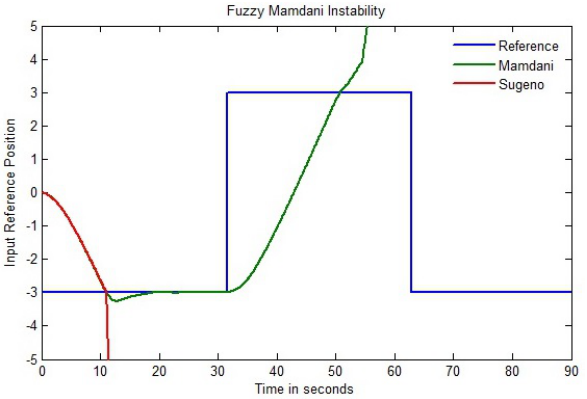
Figure 14: Fuzzy Mamdani